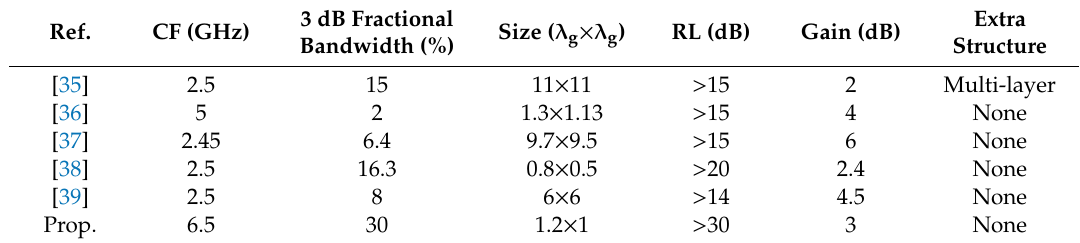
Table 3. Comparison between the proposed design and